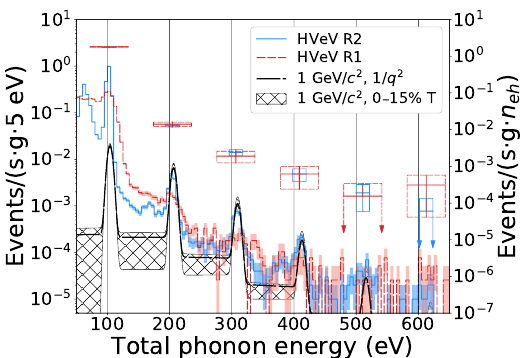
Figure 10: Energy spectra acquired during SuperCDMS-HVeV Run1 (R1) and Run2 (R2). An additional point is added above each electron-hole pair peak to highlight the event rate contained in a 3 σ window around the peak (corresponding to the counts in the peak). Each point has a 3 σ uncertainty on the number of counts. The black curve represents a DM-electron scattering model with DM form factor F and a DM mass of 1 GeV / c 2 for an impact ionization of 2% and for a charge trapping of 11%. The uncertainty considers the trapping varying in the range 0 - 15%. Figure and caption from Ref. [ 50 ]